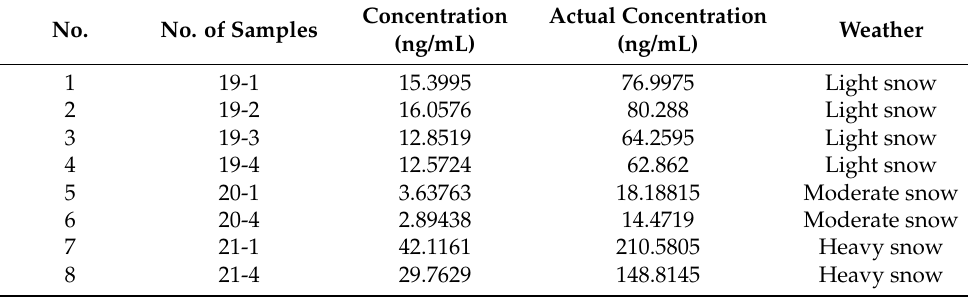
Table 1. Summary of BC concentration and actual concentration.